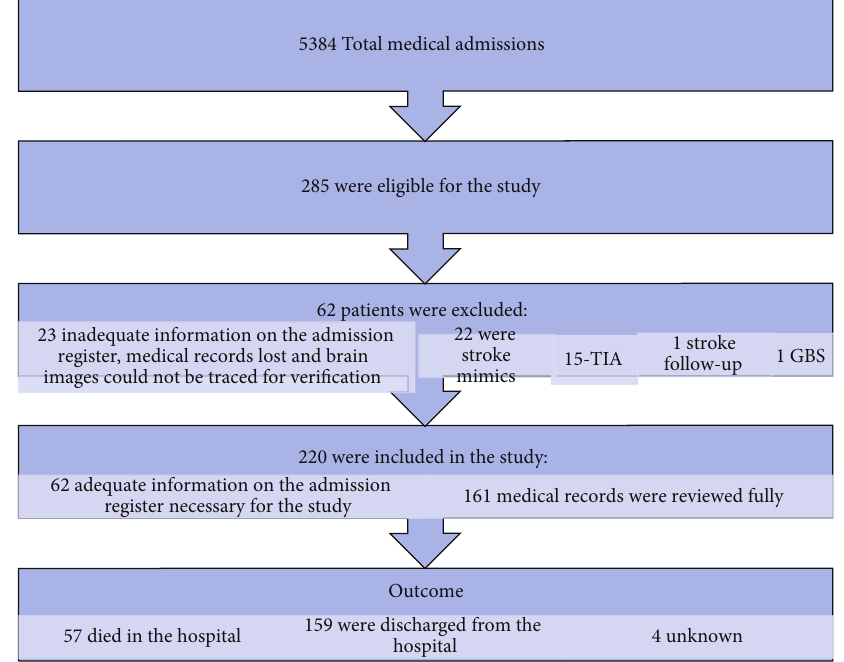
Figure 1: Study fl owchart. Abbreviations: TIA: transient ischaemic attack; GBS: Guillain-Barré